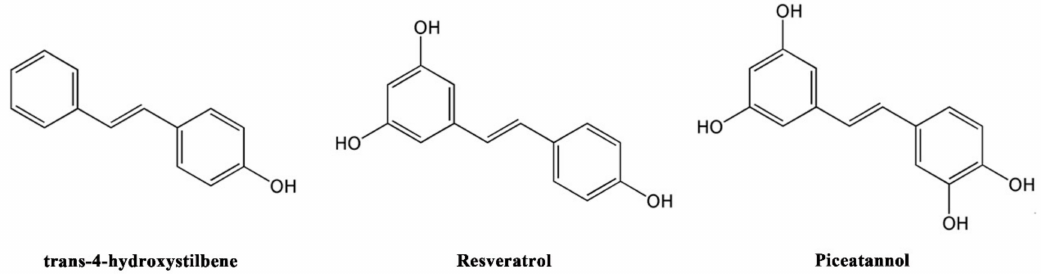
Figure 1. The chemical structure of three